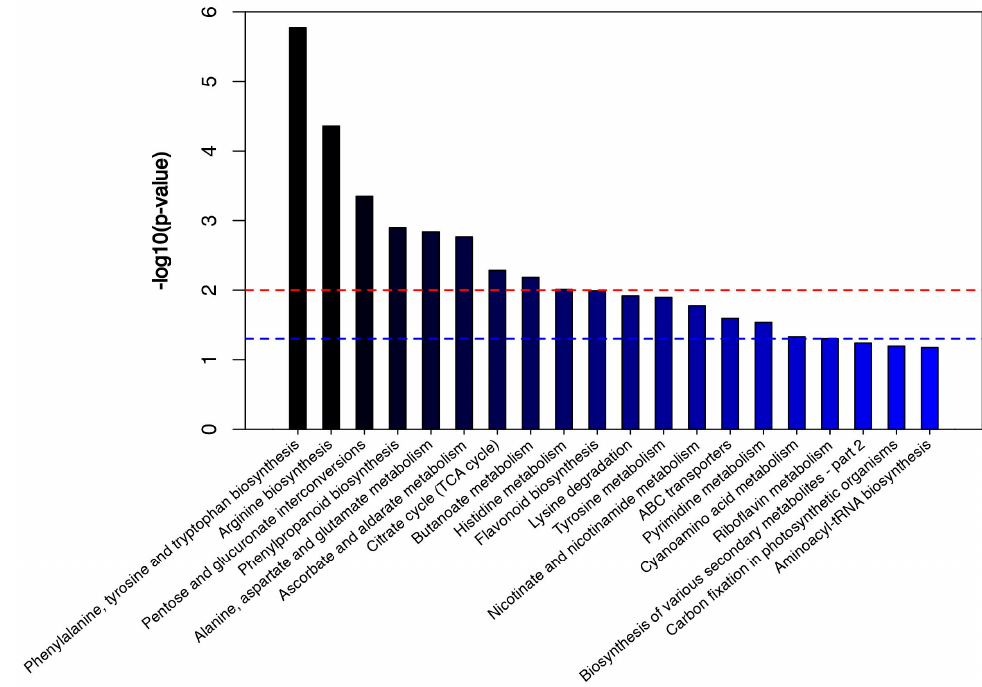
Figure 10. Enrichment of metabolic pathway were analysed by conbination with GC-MS and LC-MS. Bars that exceed the blue and red dotted lines indicate pathways with p < 0.05 and p < 0.01, respectively.